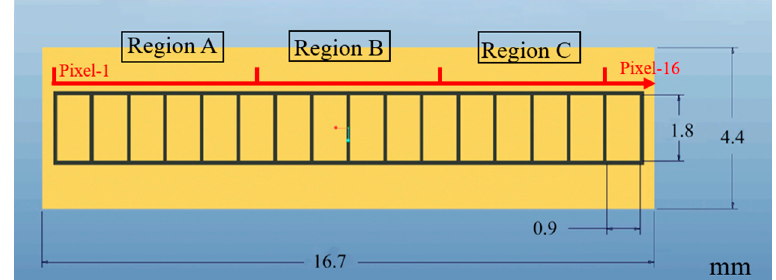
Figure 1. Schematic diagram of the detailed anode structure containing the location information of pixel 1 to 16 and region A to C.